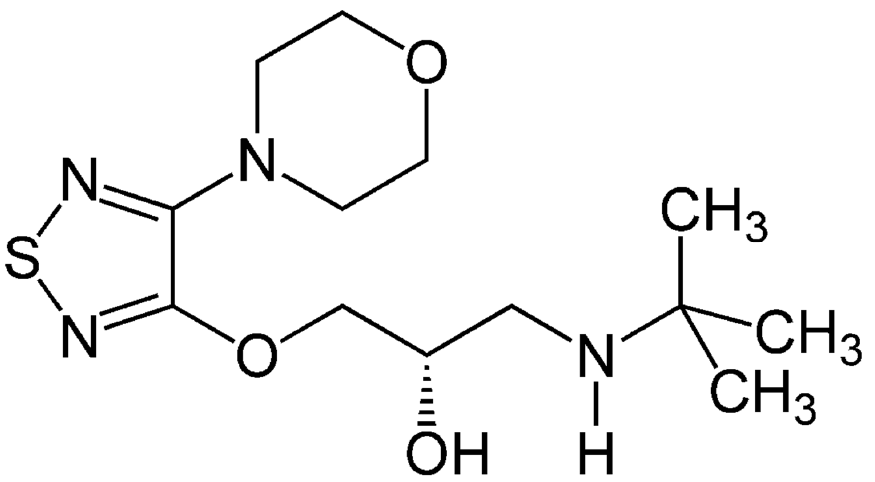
Figure 1. Demonstrates the monomer structure of the Timolol medication. Sites available allow for increased drug-release efficiency, due to the hydrogen-bonding sites present